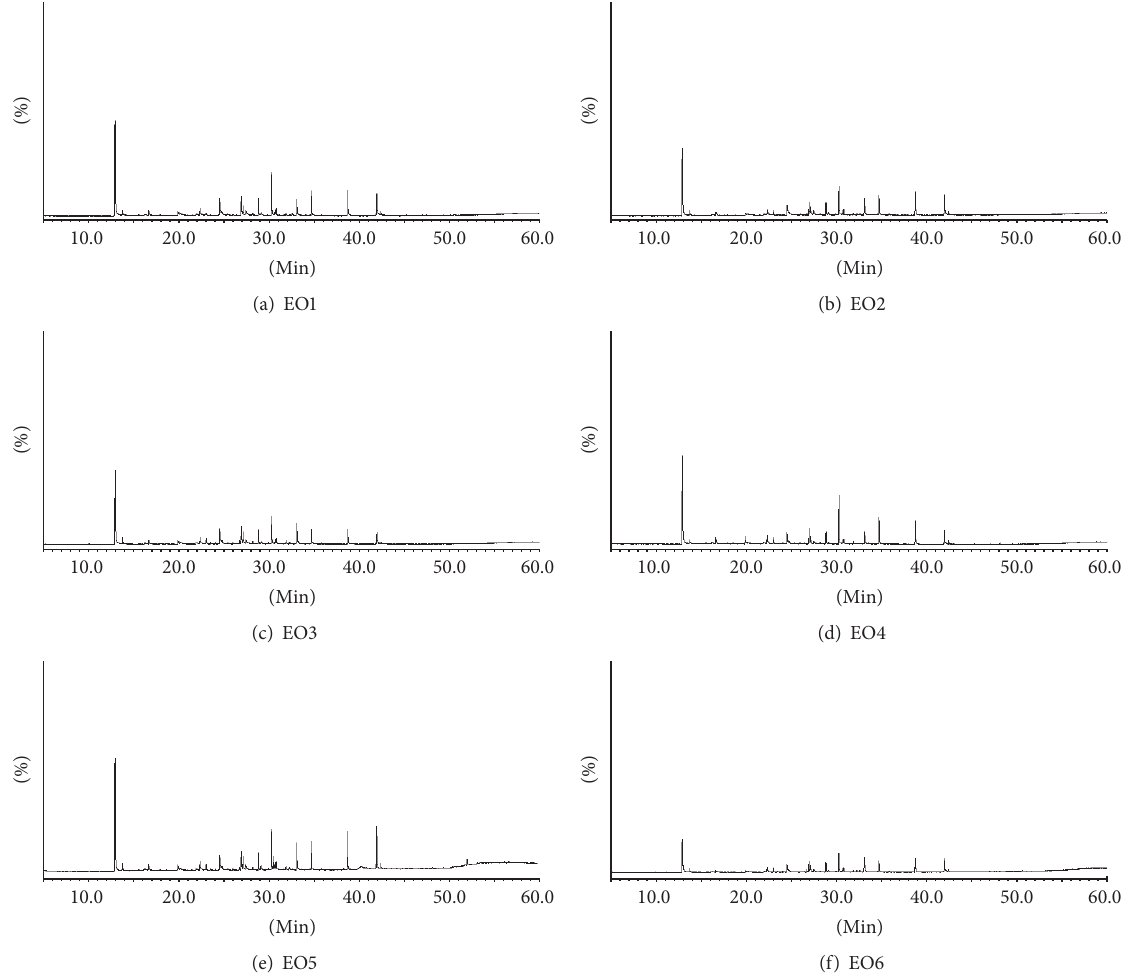
Figure 2: Gas chromatograms of